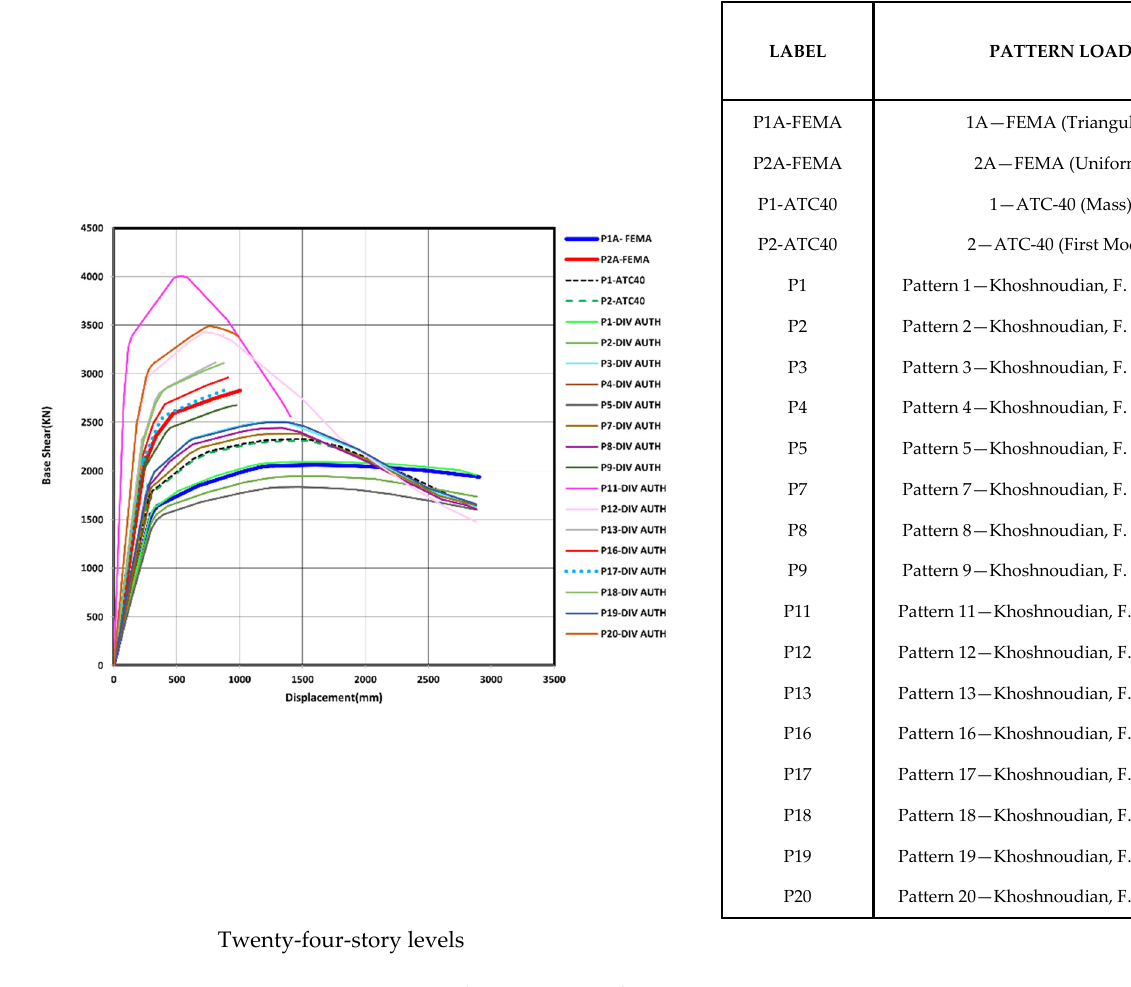
Figure 5. Nonlinear static pushover curves.